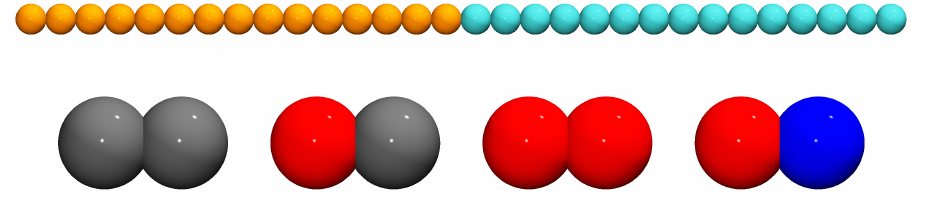
Figure 1. Model di-BCP chain with h-block beads in orange and t-block beads in cyan ( top ); and model nanodimers with neutral ( grey ), head-like ( red ) and tail-like ( blue ) beads ( bottom ). Table 1. Force-field parameters employed in Equations (1) and (2), respectively, describing the non-bonded and bonded interactions of h-block and t-block chain beads and H, T and 0-ND beads. For all interactions, r c = 2 1/6 σ . All parameters are invariant under subindex inversion ( A αβ = A βα ). Bead Non-Bonded